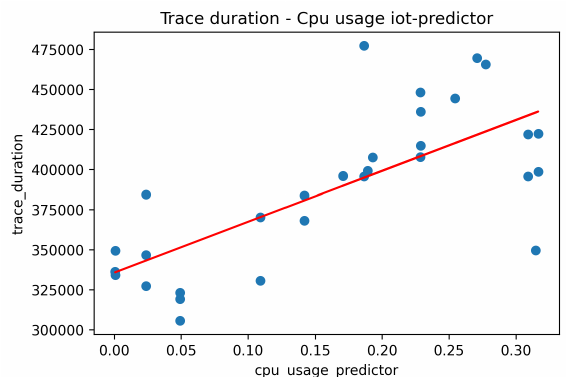
Figure 14. Correlation between trace duration and CPU usage—IoT Predictor component.